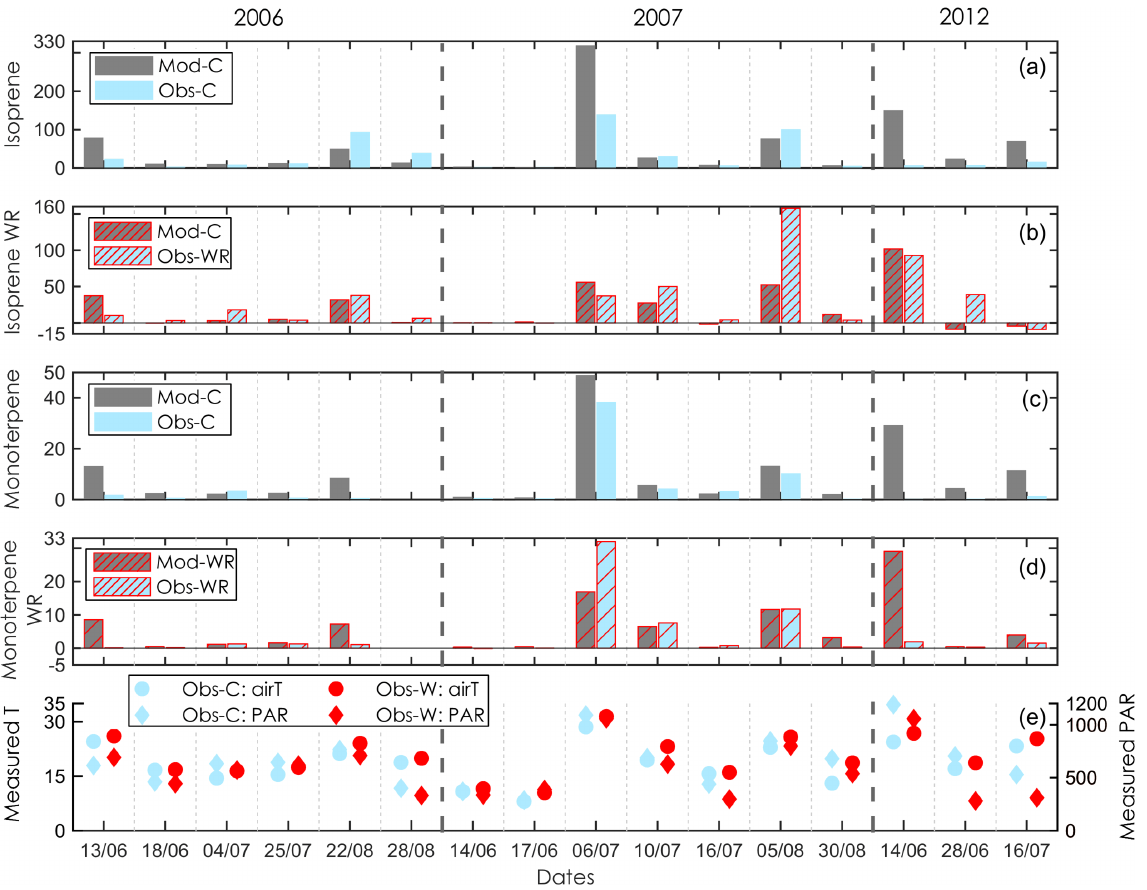
Figure 4. Comparison of the modelled (a) isoprene and (c) monoterpene emission rates with the observations in the control (C) plots and evaluation of modelled warming responses (WRs) with the observed WRs (b, d) at the Abisko tundra heath. The observed enclosure air temperature (air T ) and PAR outside the enclosure are displayed in (e) . Mod: modelled; Obs: